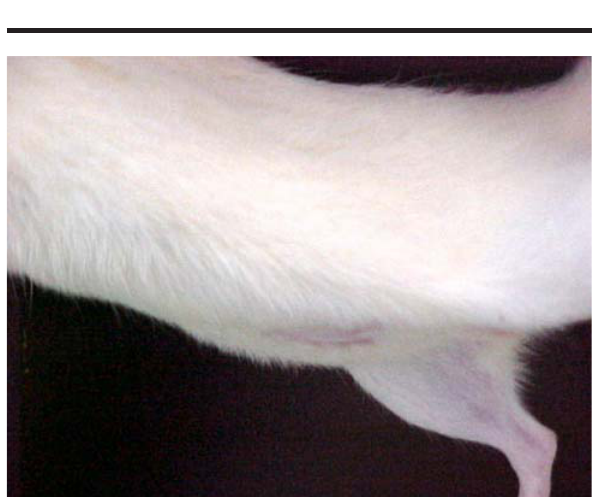
FIGURA 1B - Aspecto do estrato músculo-aponeurótico do mesmo animal, após a retirada da pele e da tela subcutânea, evidenciando-se o saco herniário (SH) e o anel (setas).